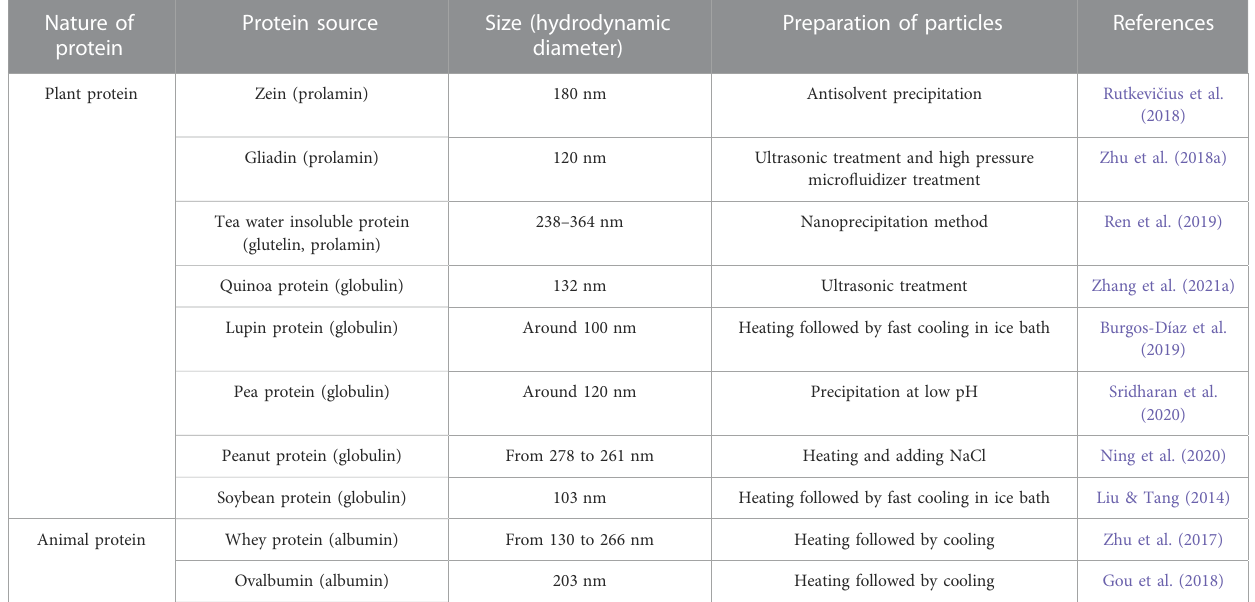
TABLE 1 Examples of proteins nanoparticles obtained from animal or vegetable proteins. Nature of